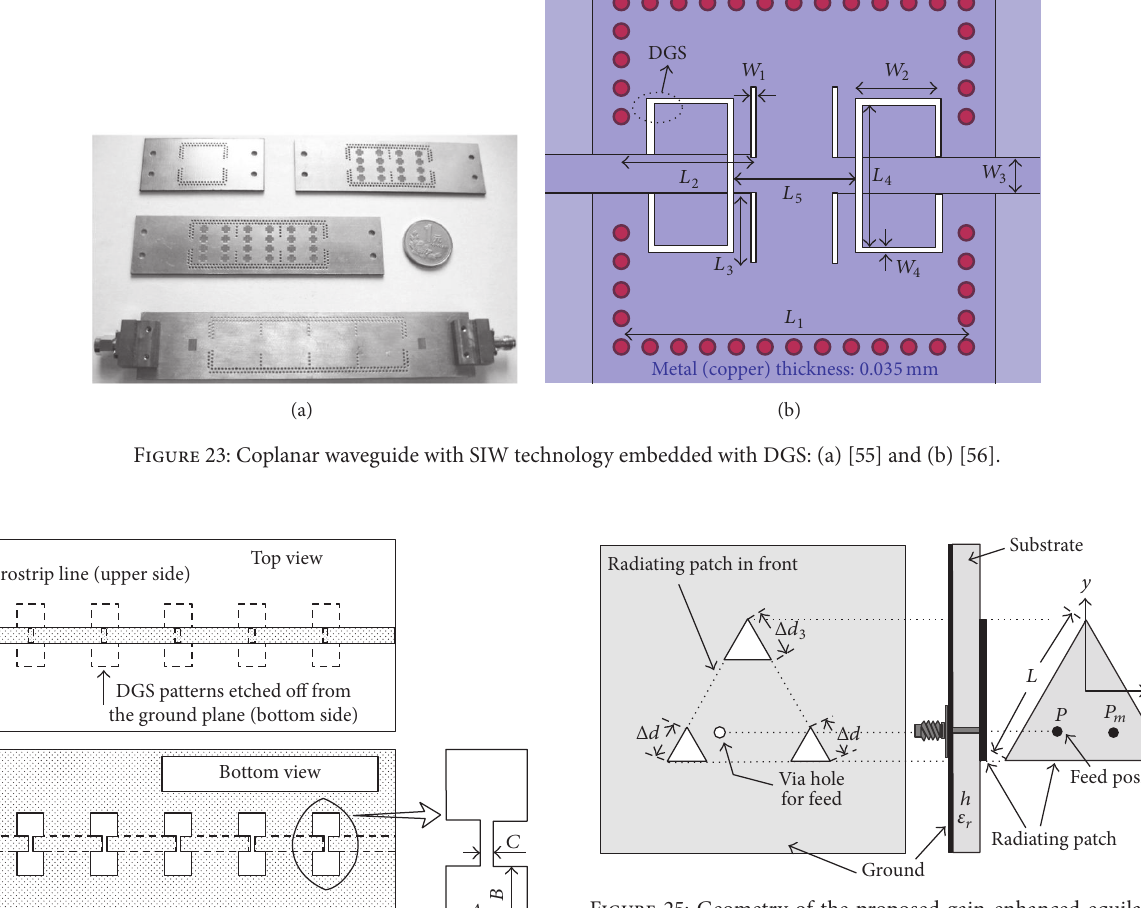
Figure 25: Geometry of the proposed gain-enhanced equilateral- triangular microstrip antenna